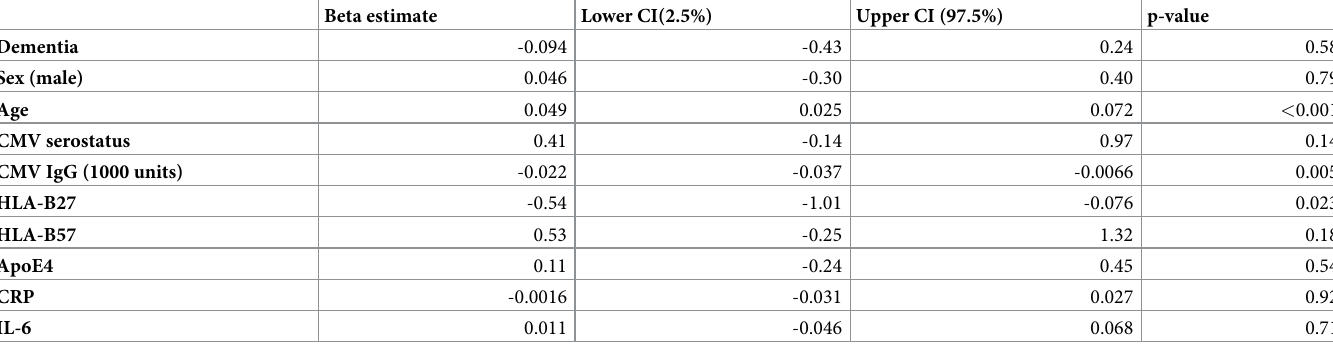
Table 3. Multivariable linear regression model of TTV viral load predictors. Only TTV positive subjects included in the analysis.